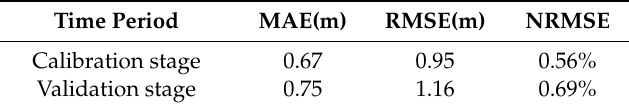
Table 3. Evaluation index of groundwater level simulation e ff ect.